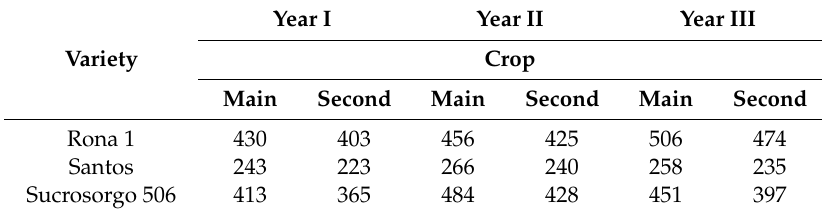
Table 4. Bioethanol yield from sorghum straw (L · Mg − 1 of straw